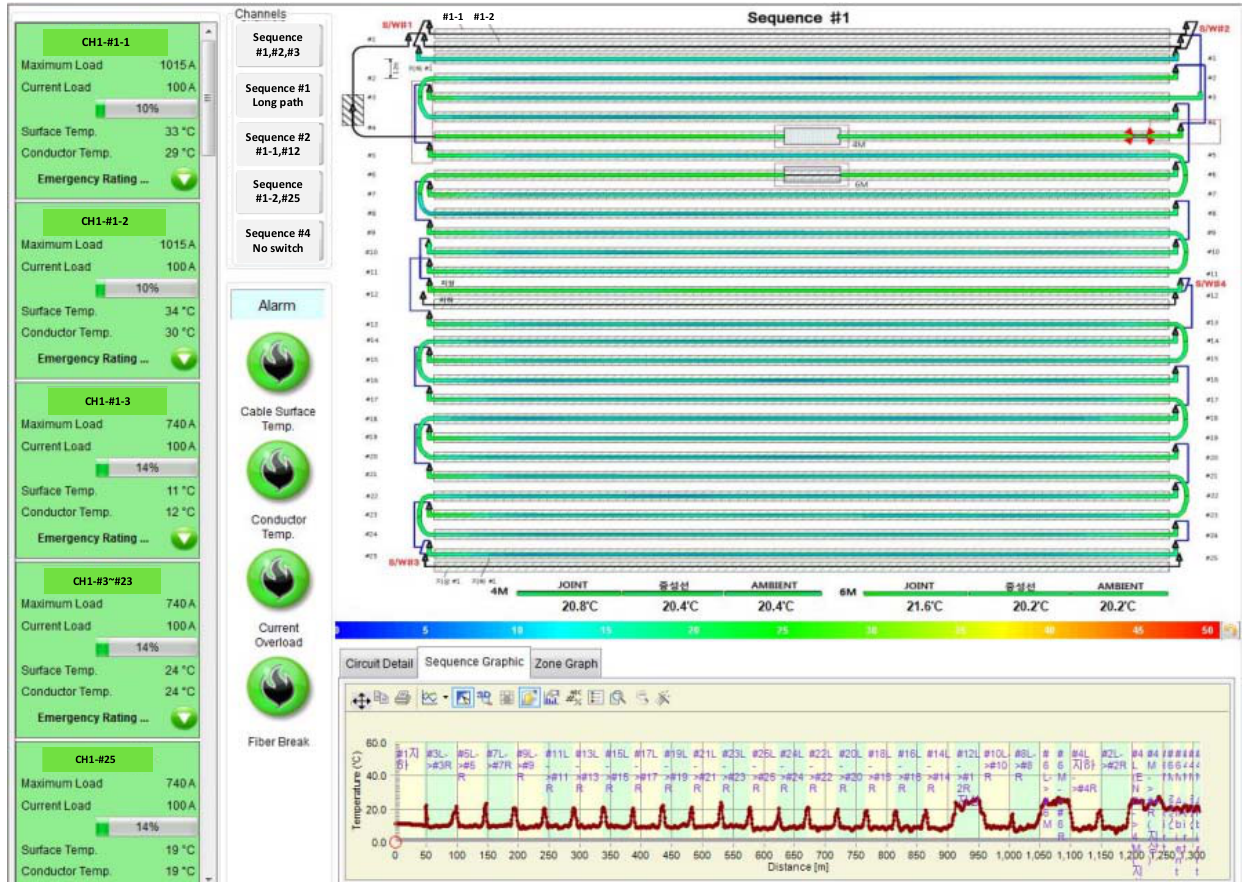
Figure 17. Monitoring operation of the intelligent cable monitoring system after